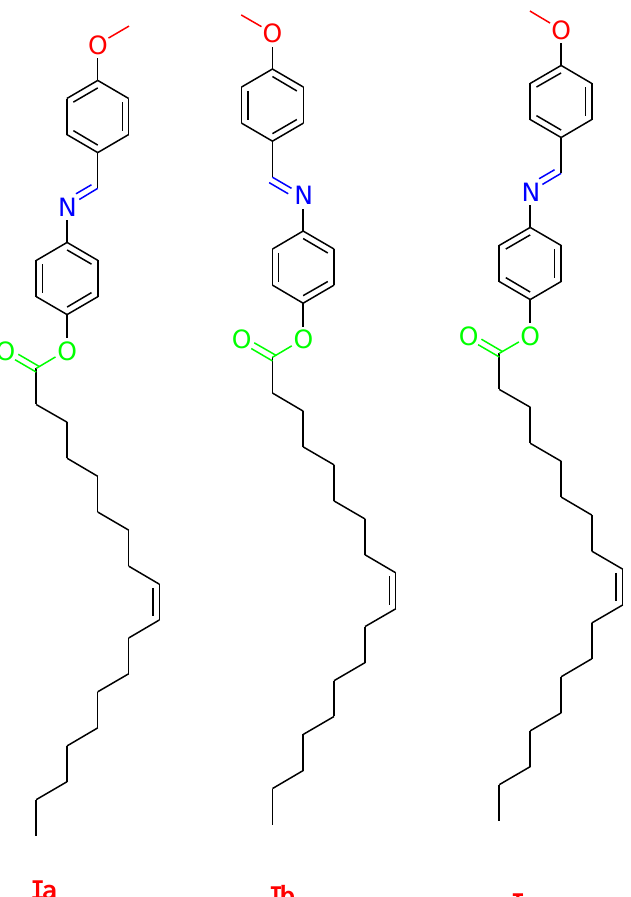
Figure 13. The proposed configurational isomers ( Ia – c ) of the prepared compound I .